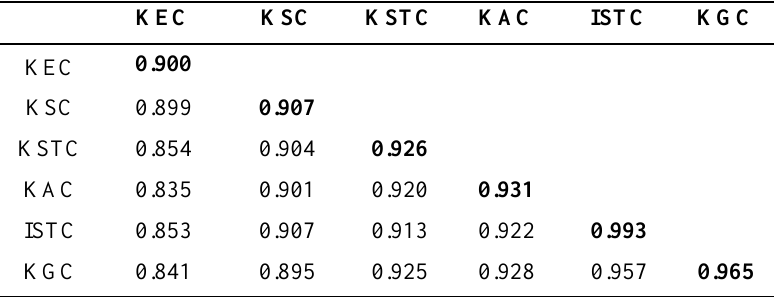
Table 4: Discriminant Validity of Second Order